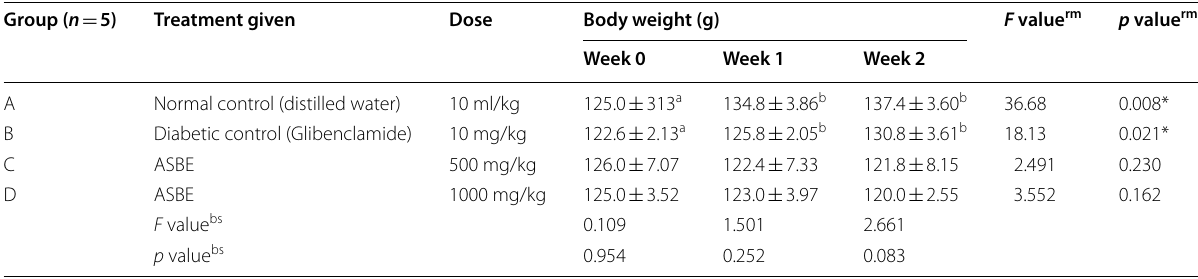
Table 2 Effect of aqueous stem bark extract of B. dalzielii on body weight